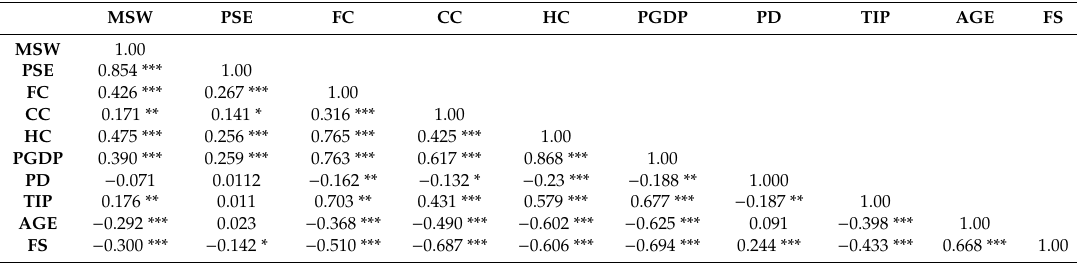
Table 4. Results of correlation analysis.